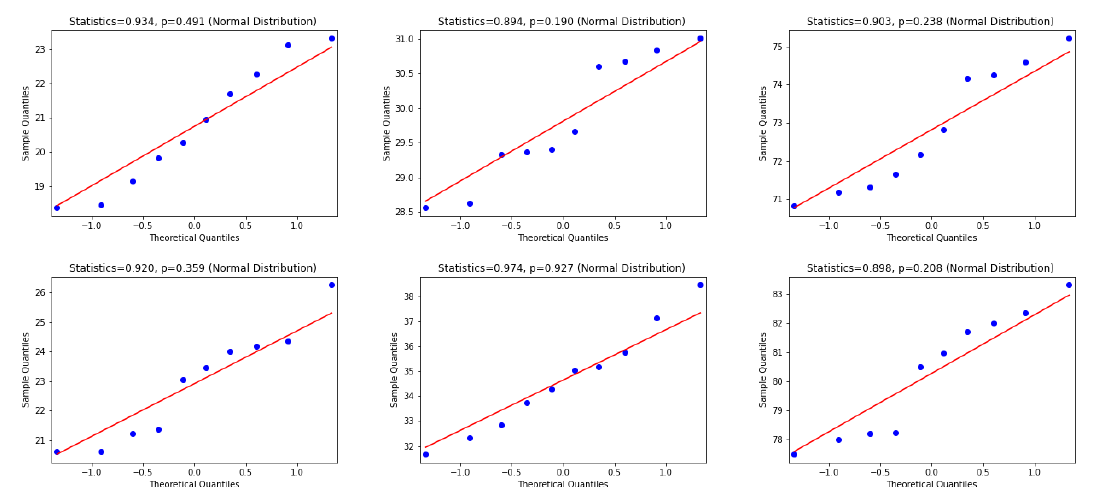
Figure 8. This figure provides Quantile–quantile plots with the p -values of the Shapiro–Wilk test for the differences between CER, WER, and SER results in Section 5.2 represents the distributions of Puigcerver that are computed in terms of test1 and test2 dataset.